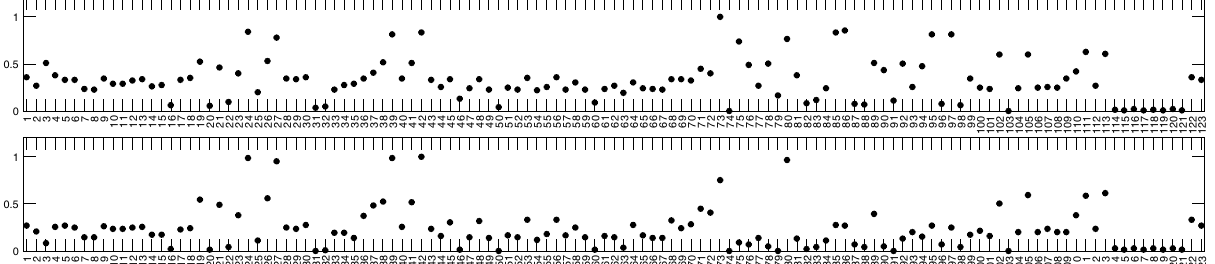
Figure 4. Parameters ranking for the ATM/p53/NF- κ B signaling pathway model described in Jonak et al. 12 . Simulation was performed with two input signals: (TOP PANEL) 10 ng/ml TNF and 4 Gy IR; (BOTTOM PANEL) 10 ng/ml TNF and 10 Gy IR. Parameter names corresponding to the numbers on the ranking are given in Supplementary Table